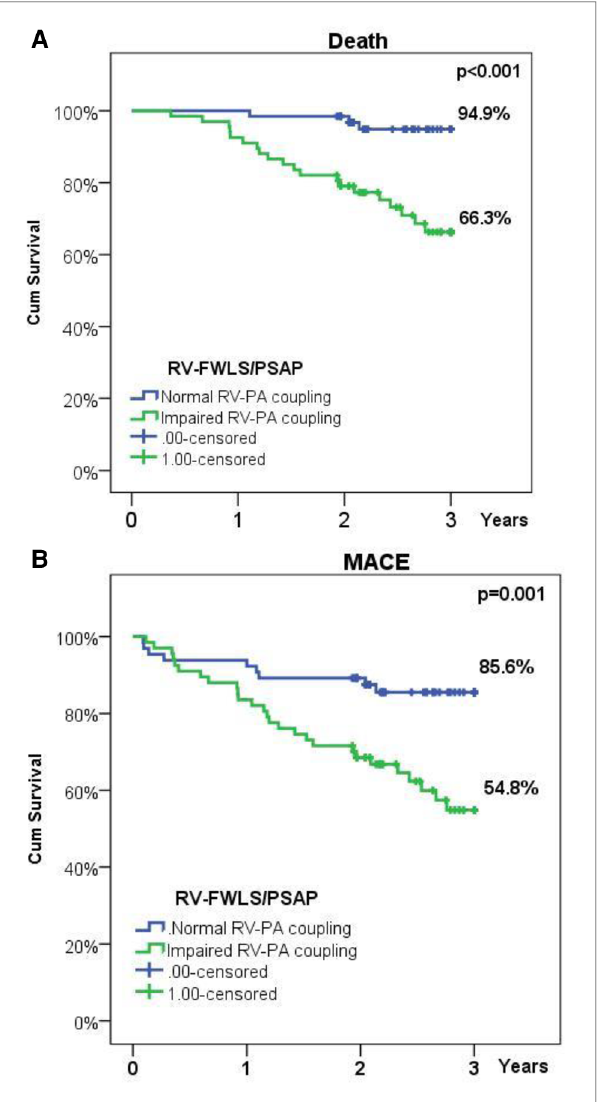
FIGURE 2 ( A ) Kaplan-Meier survival plot illustrating survival in patients with normal or impaired baseline RV-PA coupling; ( B ) Kaplan-Meier survival plot illustrating freedom from rehospitalization or death in patients with normal or impaired baseline RV-PA